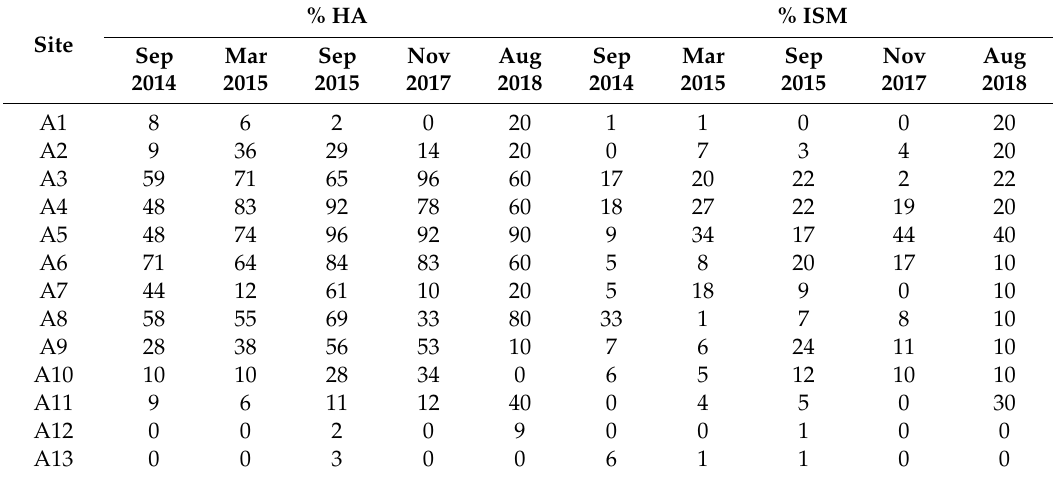
Table 5. Percentage of highly annoyed (% HA) and percentage of insomnia (% ISM). % HA % ISM Site